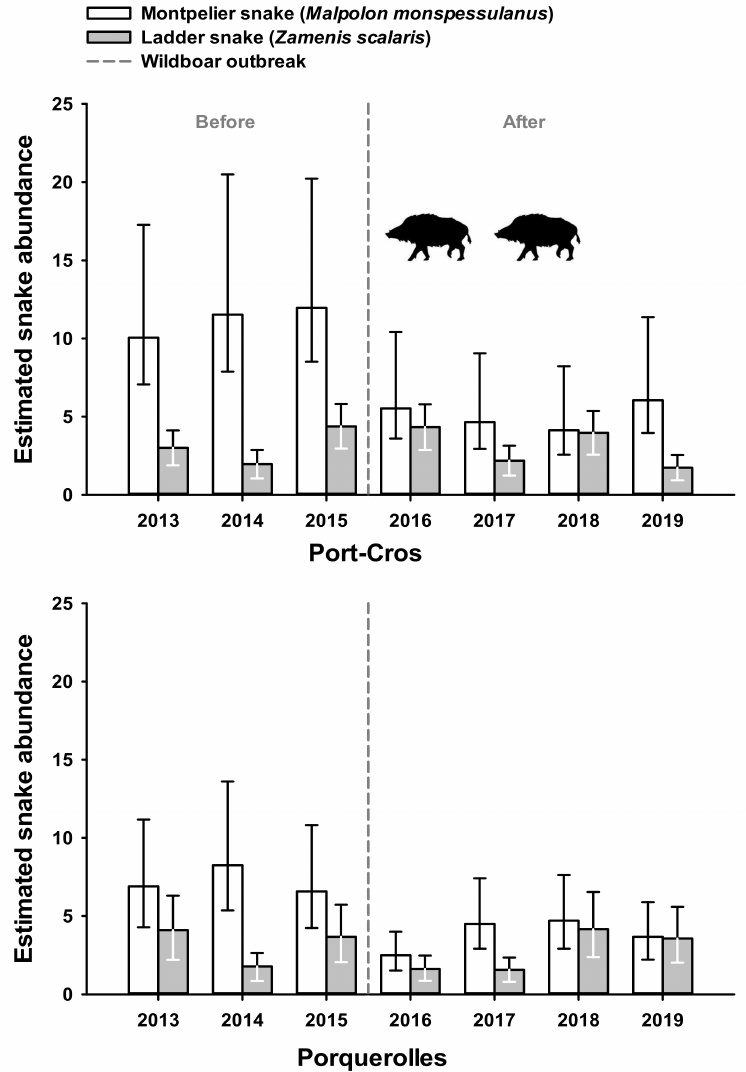
Figure 3. Annual abundance of the species of snake ( M. Monspessulanus or Z. scalaris ) was assessed using a generalized linear model to estimate the number of snakes encountered during a daily transect (Y axis, see text for details). Error bars represent lower and upper 95% confident interval respectively. Vertical dashed lines indicate the time limit before and after wild boar outbreak that occurred in Port-Cros (upper panel), but not in Porquerolles (lower